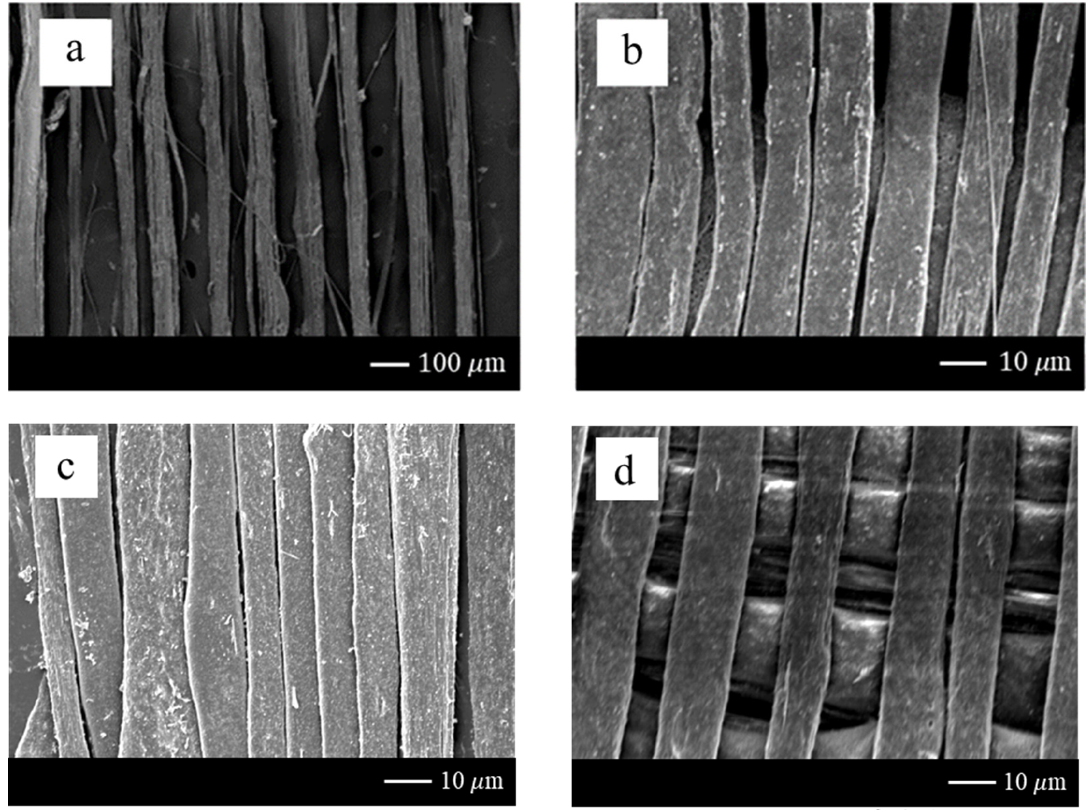
Figure 19. Density analysis of electrospinning: ( a ) 50 μ m of the pitch of the stepping motor; ( b ) 10 μ m of the pitch of the servo motor; ( c ) 7 μ m of the pitch of the servo motor; ( d ) cross-laminated fiber of the servo motor.